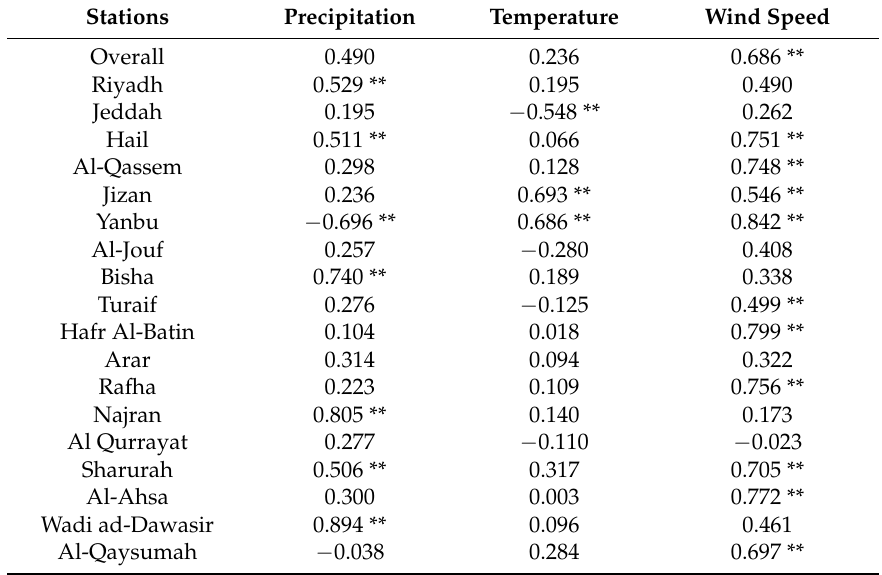
Table 2. The Pearson correlation coefficient ( r ) of the frequency of dust storms versus temperature, precipitation and wind speed considering each Presidency of Meteorology and Environment (PME) station from 2000 until